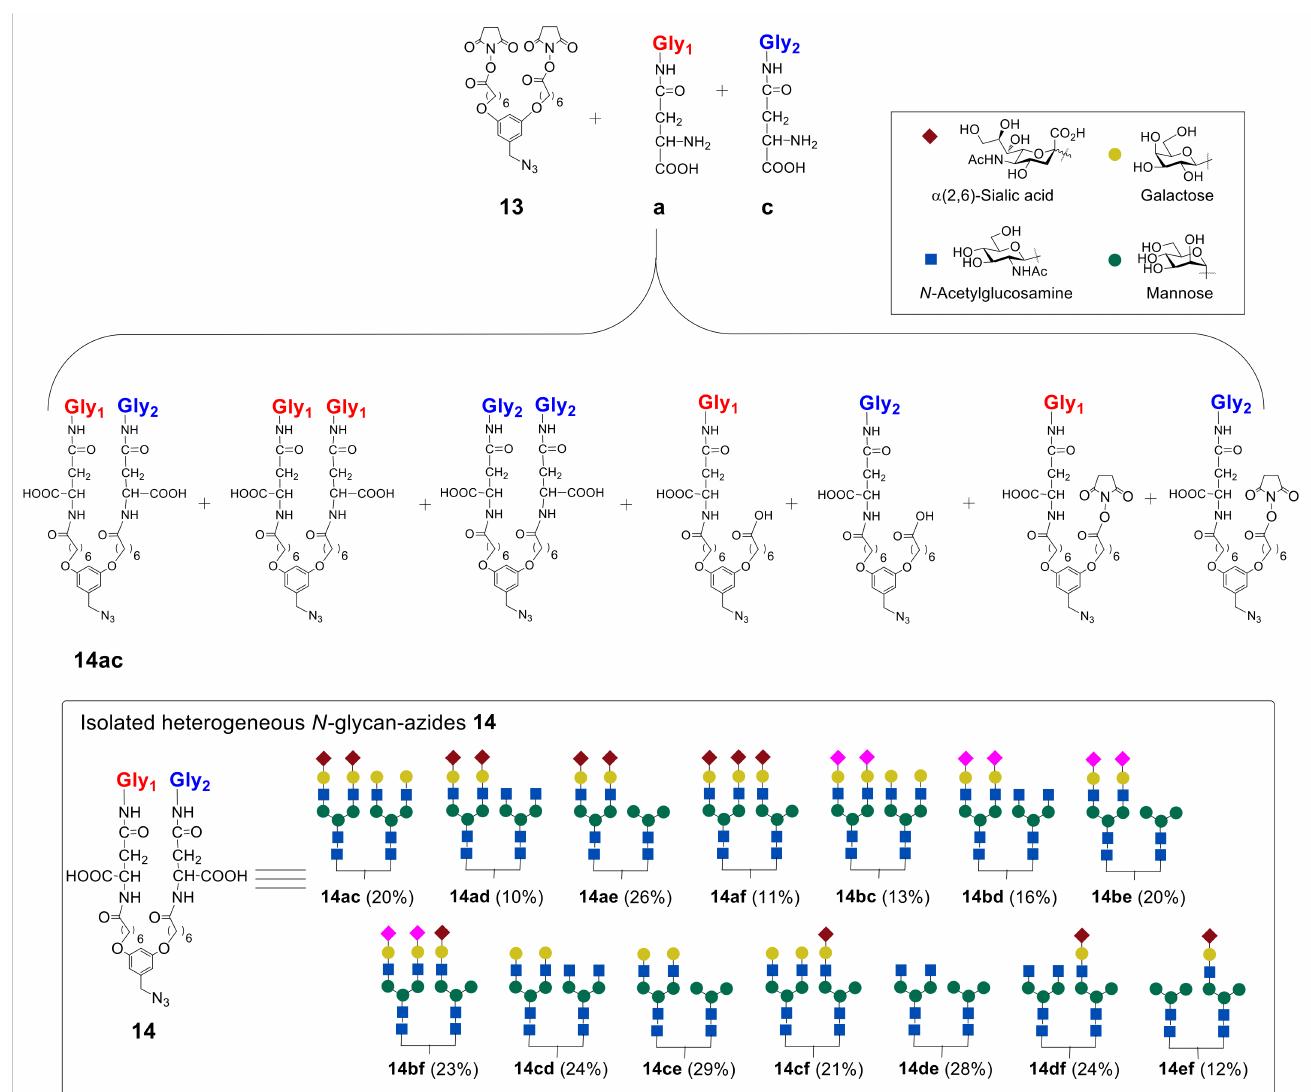
Figure 10. Reaction of azide 13 with two different N -glycans leading to the formation of heteroge- neous glycan–azides 14ac – ef , represented by the synthesis of 14ac [44]. Copyright Wiley-VCH GmbH. Reproduced with